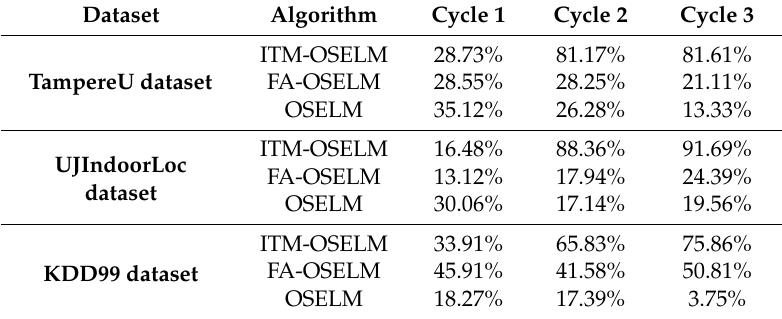
Table 2. The overall accuracy in each cycle for ITM-OSELM, FA- OSELM and OSELM in the three datasets.